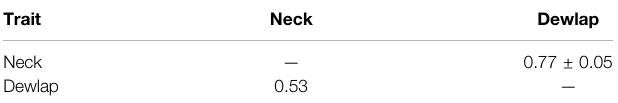
TABLE 5 | Estimated genetic correlation ± standard error (above diagonal) and phenotypic correlation (bellow diagonal) for scored autochthonous traits from Group 3.